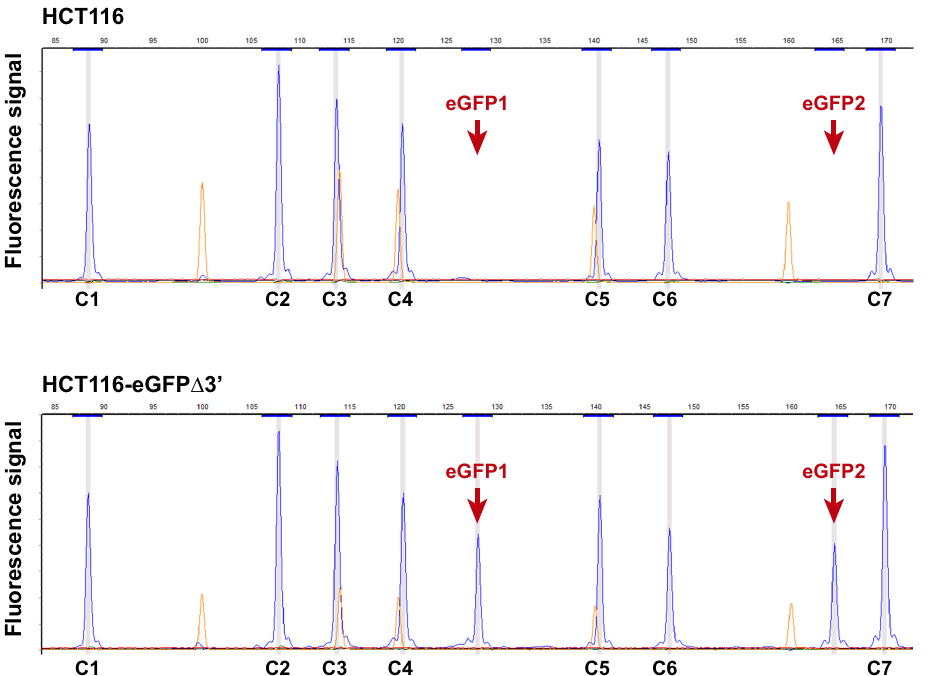
Fig 2. MLPA analysis for eGFP Δ 3’. Electropherograms from parental HCT116 cells and the HCT116-eGFP Δ 3’ reporter cell line. Blue peaks represent signals of MLPA probes used for the indicated genes. The red arrows indicate signals corresponding to eGFP1 and eGFP2 probes. The eGFP-specific MLPA probes and 7 control MLPA probes are listed in S2 Table . Orange peaks represent fragments of GS Liz600 DNA size standard.